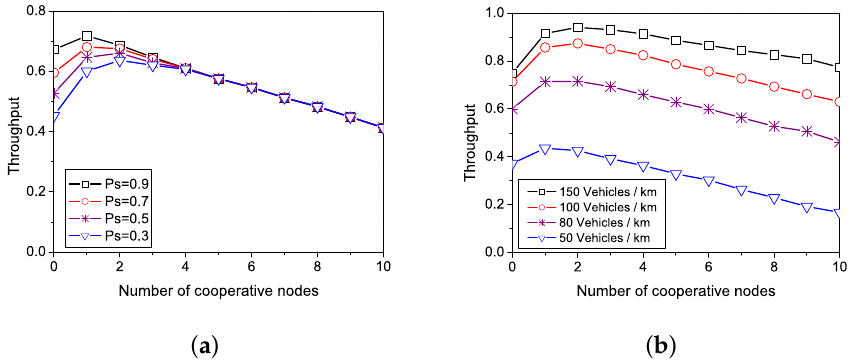
Figure 3. Network throughput. ( a ) Influence of successful transmission rate on throughput. ( b ) Influence of node density on